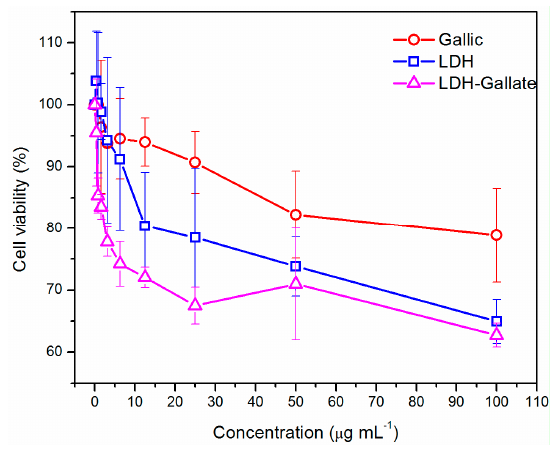
Figure 6. Cell viability of LDH, LDH ‐ gallate nanomaterials and gallic acid on A549 cell line after 24 h of treatment.